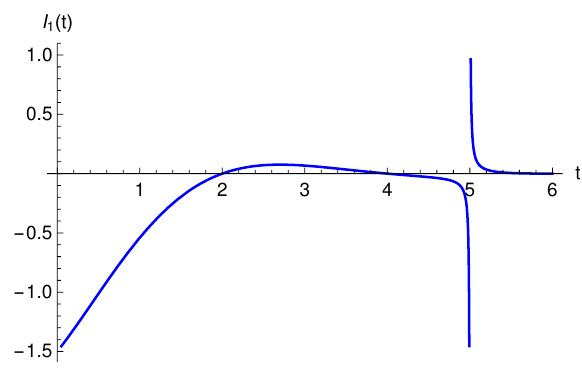
Figure 1 . The function I 1 ( t